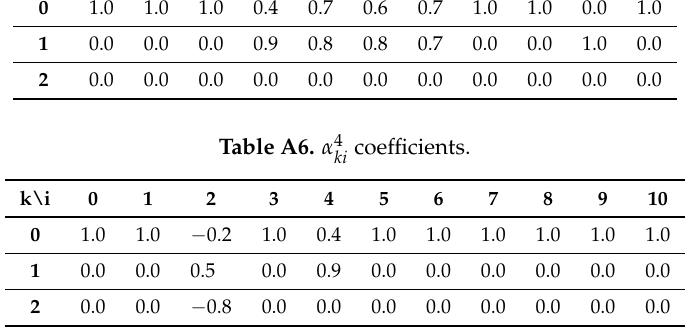
coefficients. ki